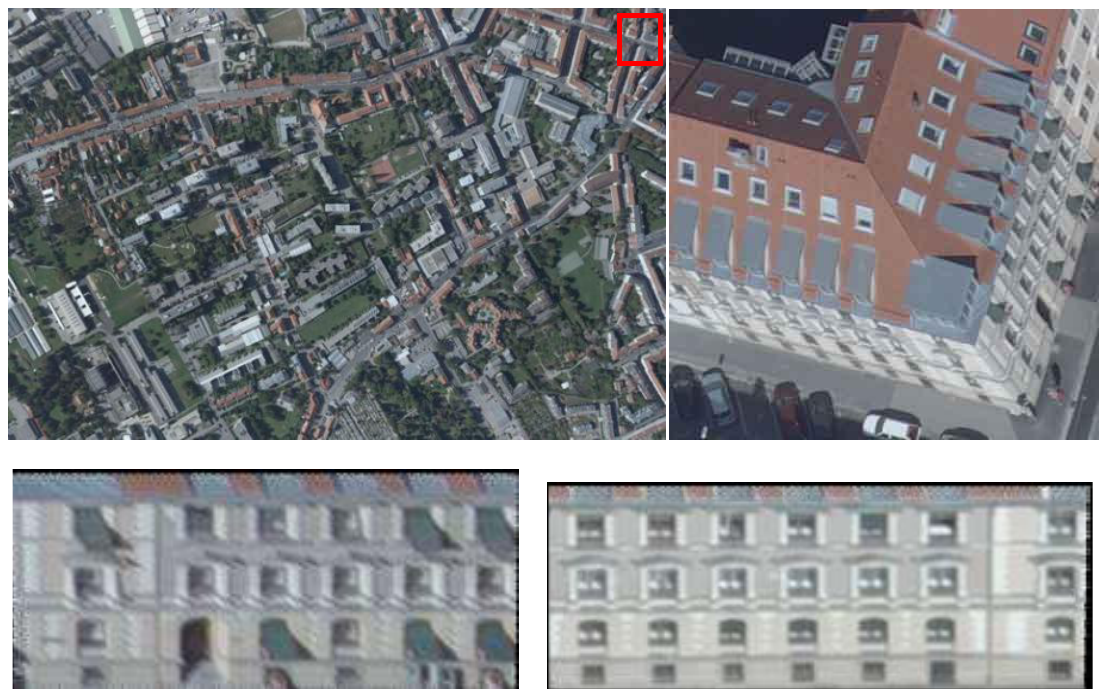
Figure 12. Two facades of one building are shown in the original vertical aerial photograph (above) and rectified into a facade plane (below) . The facade quadrilateral is superimposed over the aerial photography to obtain the photo texture for further